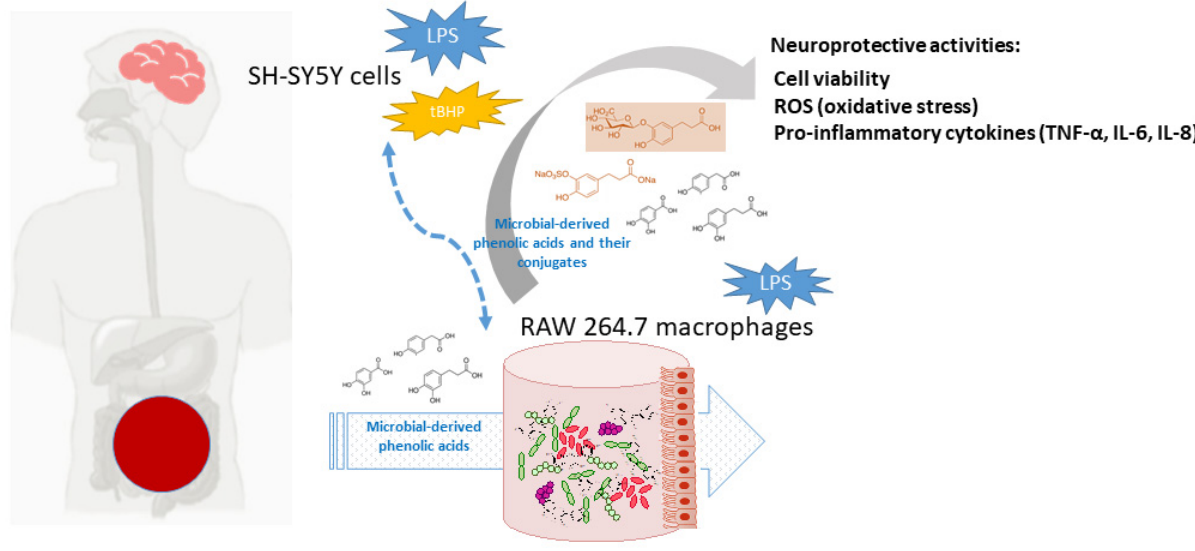
Figure 1. Schematic view of the activity of gut microbiota phenolic metabolites and conjugated forms, and putative protection against neurodegenerative disorders and AD.